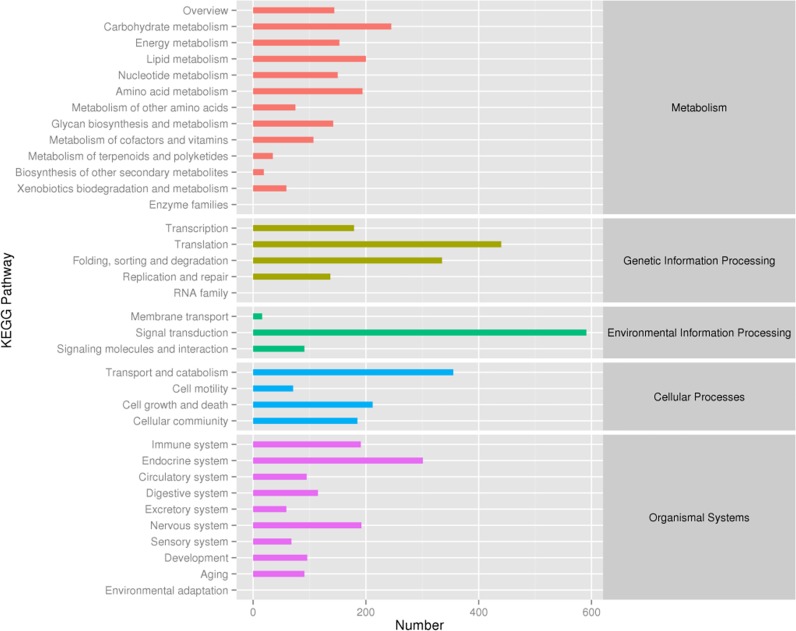
Distribution of unigene numbers for the major KEGG pathway categories in the P. trituberculatus transcriptome.